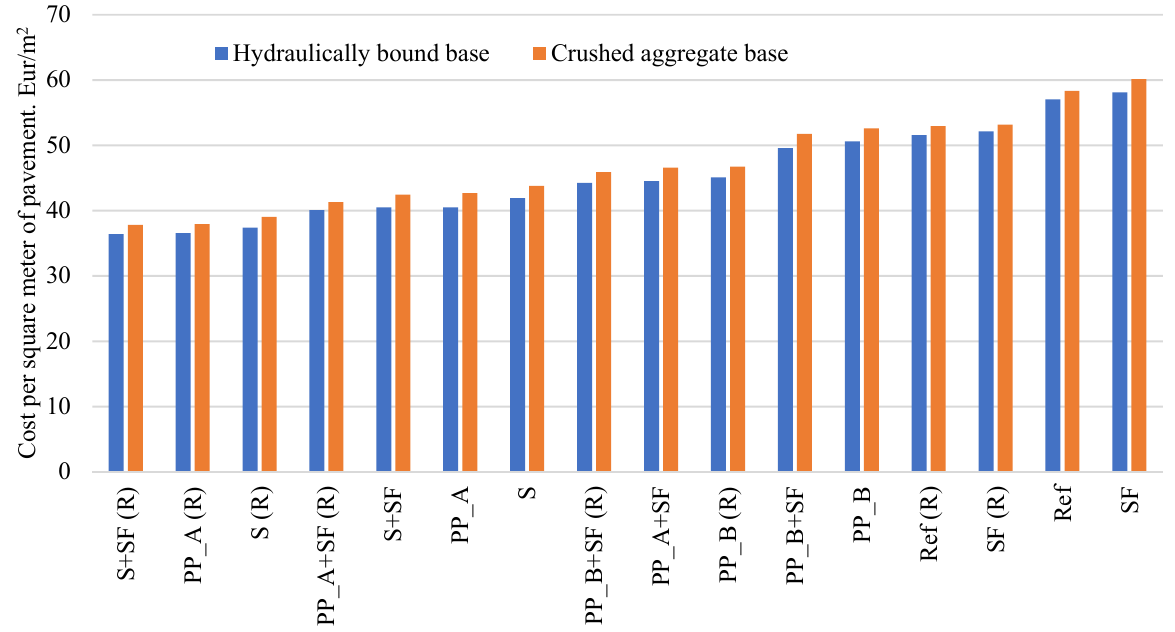
Figure 9. Cost per square meter of pavement on the crushed aggregate base and hydraulically bound base.